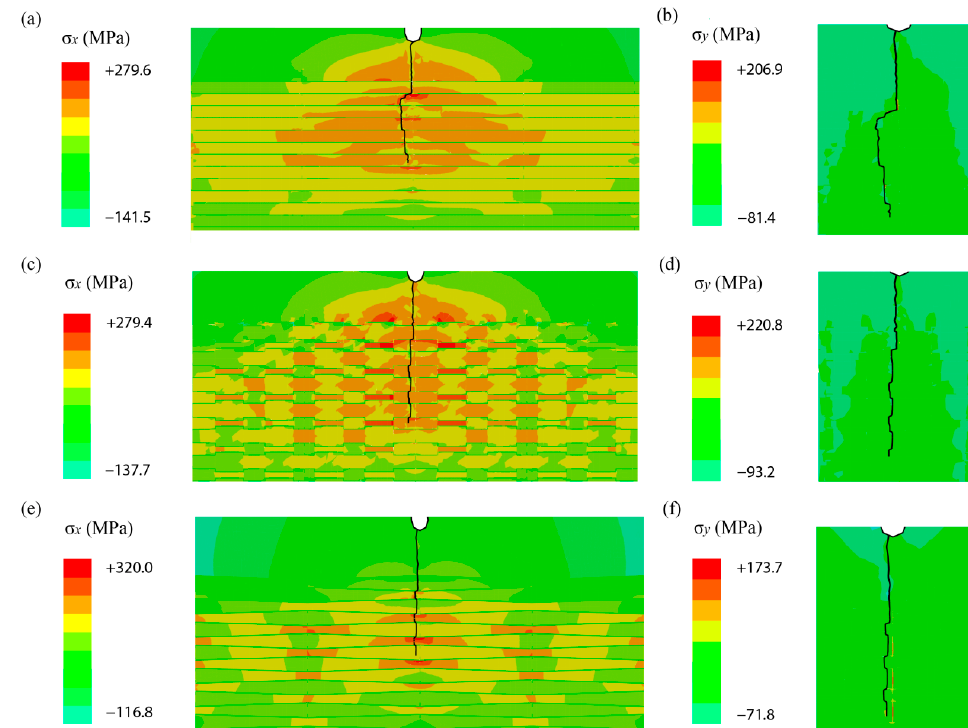
Figure 8. Crack growing path and stress distribution of different morphological models: ( a ) horizontal stress of the regular model, ( b ) vertical stress of the regular model, ( c ) horizontal stress of the racked model, ( d ) vertical stress of the racked model, ( e ) horizontal stress of the wedged model, ( f ) vertical stress of the wedged model.